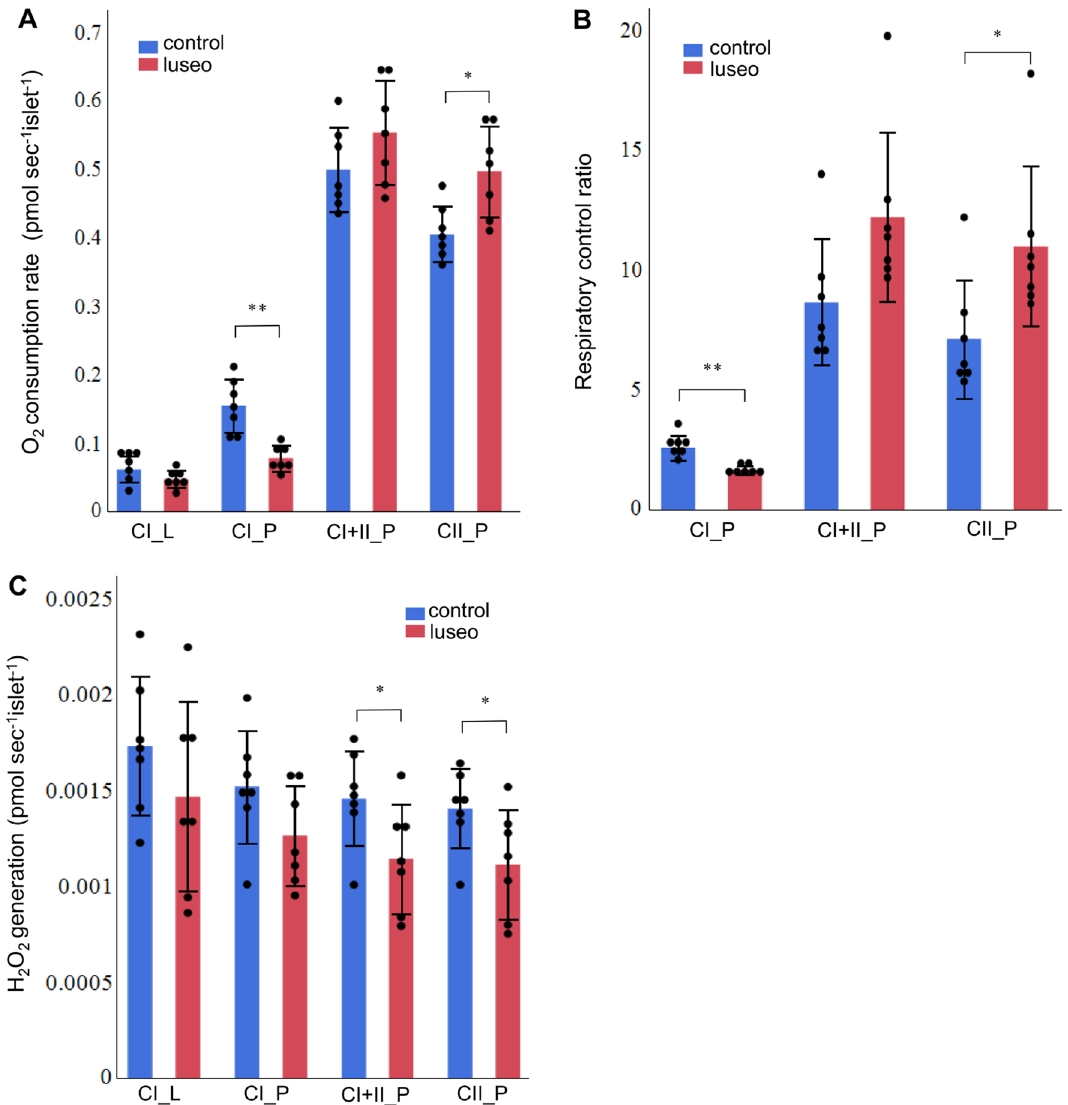
Figure 3. Effects of luseogliflozin on the mitochondrial respiratory capacity and mitochondrial ROS generation of the pancreatic islets of 10-week-old db/db mice. ( A ) Mitochondrial respiratory capacity during each state in pancreatic islets from the control and luseo groups ( n = 7). ( B ) Respiratory control ratio with each complex substrate in pancreatic islets from the control and luseo groups ( n = 7). ( C) Mitochondrial H 2 O 2 generation during each state in pancreatic islets from the control and luseo groups ( n = 7). Values are mean ± SD. P values were determined using Student’s t test. * P < 0.05; ** P < 0.01. CI, complex I-linked substrates; CI + II, complex I + II-linked substrates; CII, complex II-linked substrates; L , leak state; P , oxidative